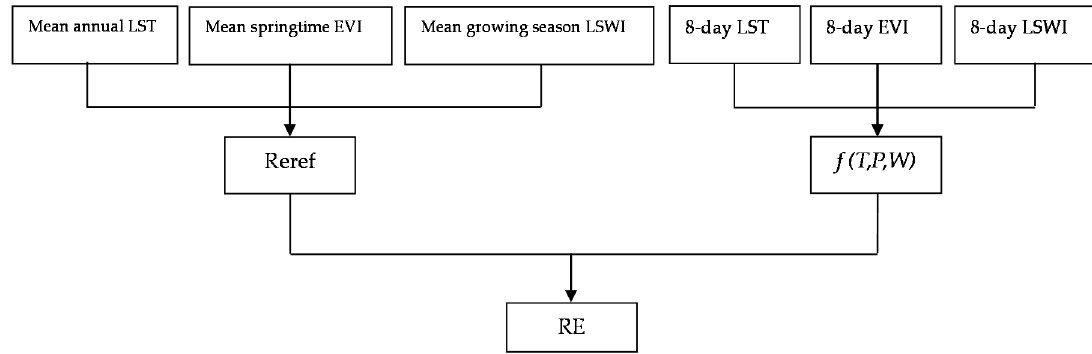
Figure 2. Structure of the ecosystem respiration ( RE ) model for grasslands.